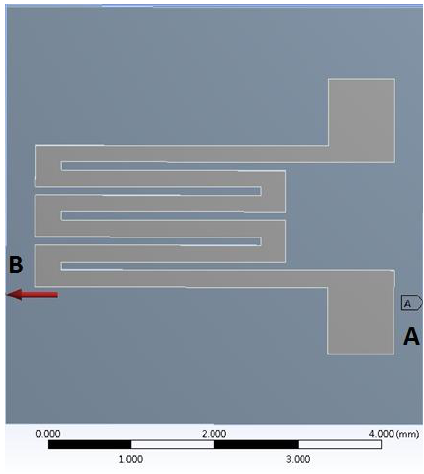
Figure 7. Boundary conditions of PDMS simulation. Right side ( A ) was fixed and the pressure applied on left side ( B ) was 0.2415 MPa.